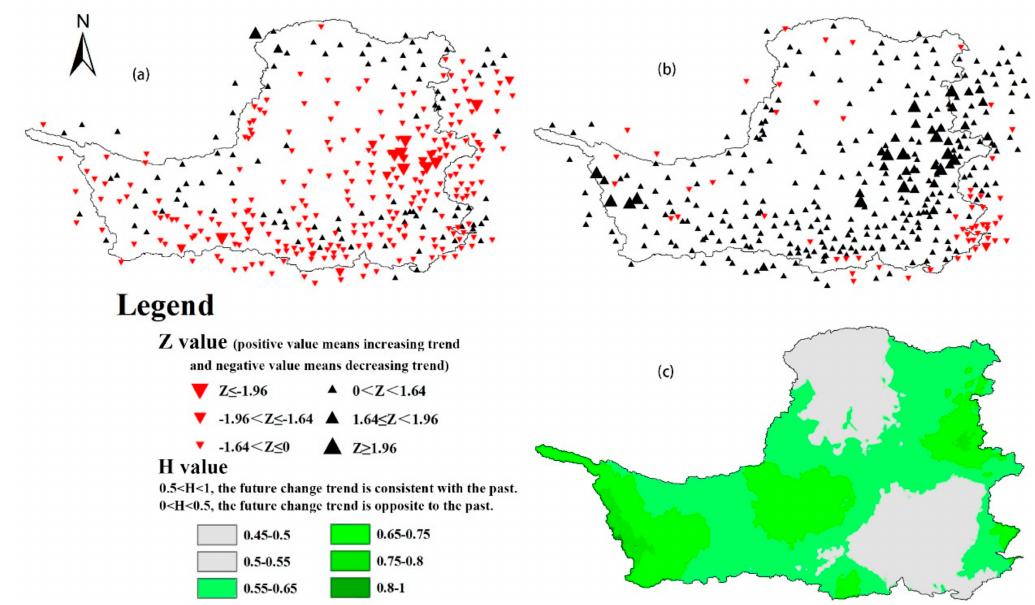
Figure 4. The Z value based on the Mann–Kendall (M-K) test used to study the trend of precipitation in Period I ( a ) and Period II ( b ), and the H value based on Hurst analysis used to study the continuity of precipitation after the Grain for Green Project (GFGP) ( c ).